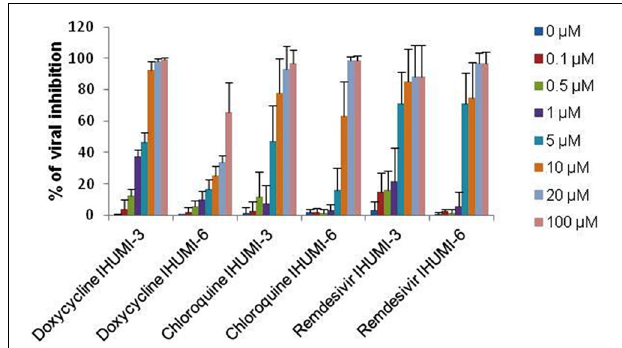
FIGURE 5 | Anti-SARS-CoV-2 activity of doxycycline, chloroquine and remdesivir in % of antiviral inhibition on IHUMI-3 and IHUMI-6 clinically-isolated strains (error bars represent standard deviation of 7–10 independent experiments).